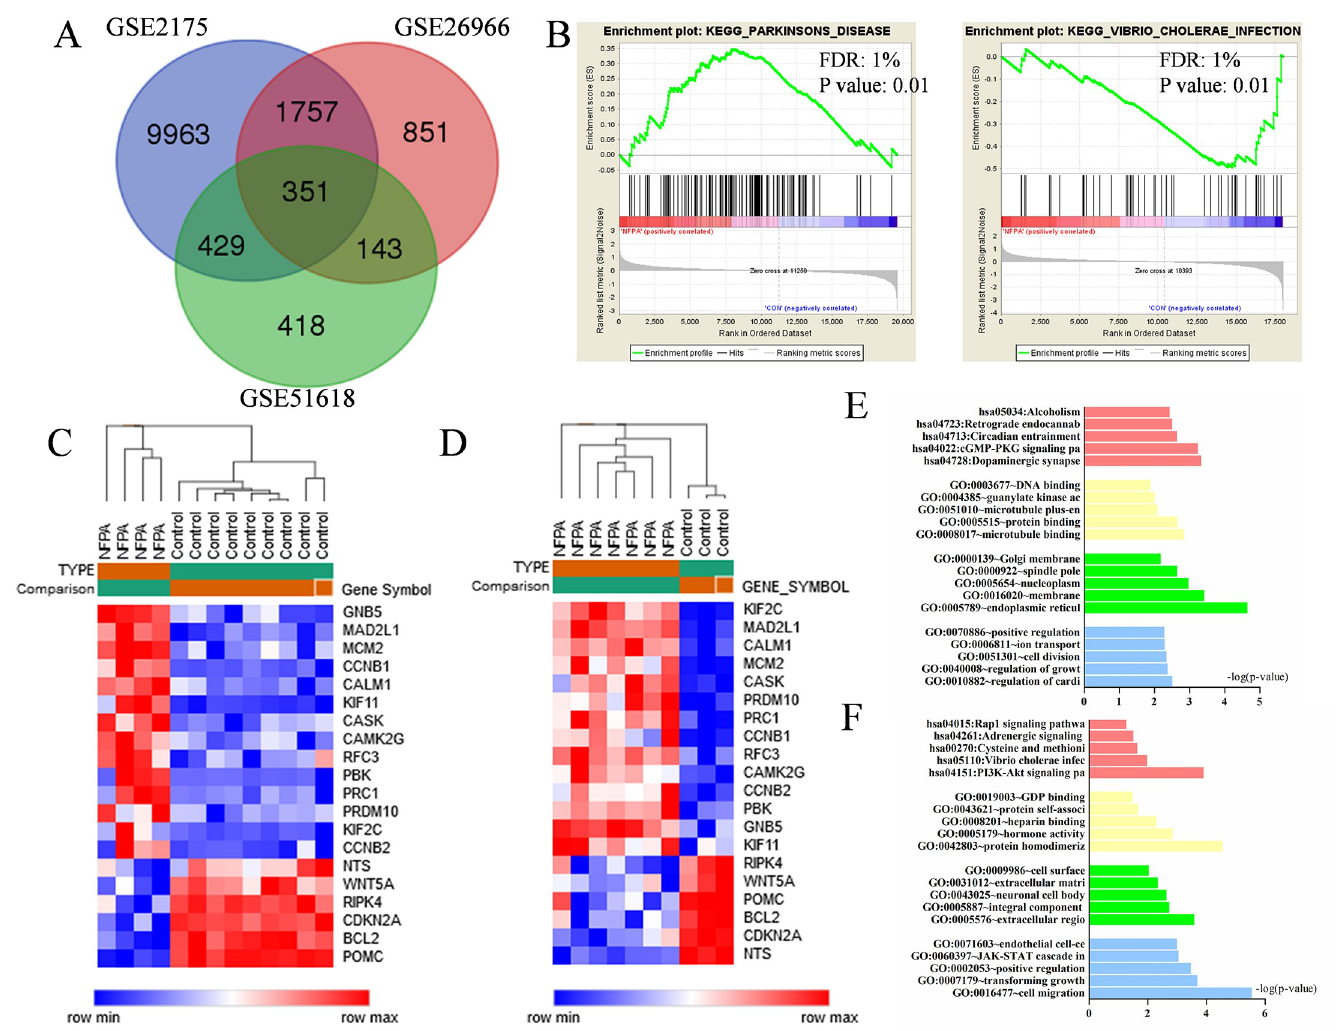
Fig 2. (A) The Venn plot of DEGs among three datasets (B) GSEA analysis results (C) Hub gene expression heat map of GSE26966 (D) Hub gene expression heat map of GSE51618 (E) Functional and pathway enrichment analysis of up-regulated genes among three datasets (F) Functional and pathway enrichment analysis of down-regulated genes among three